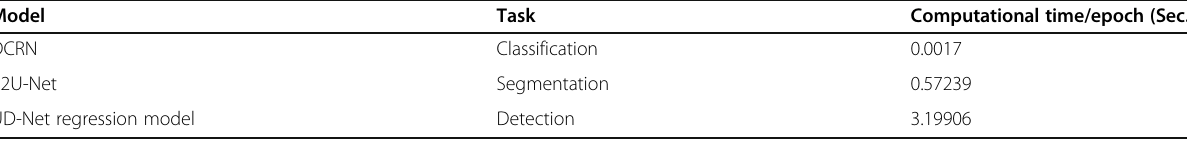
Table 4 Computational time for the DCRN, R2U-Net, and UD-Net models in the testing phase in seconds